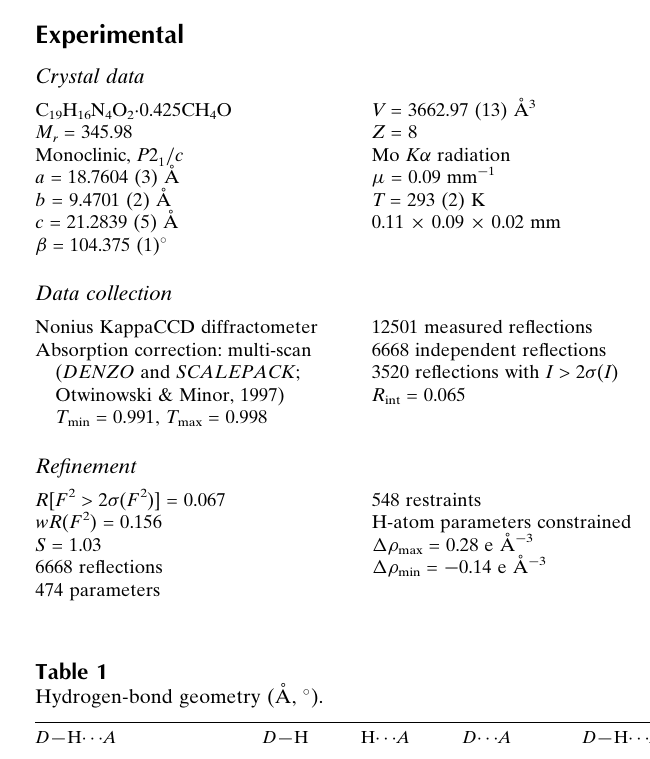
Hydrogen-bond geometry (A˚ , (cid:3)